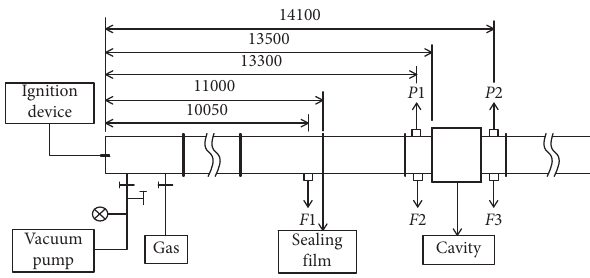
Figure 10: Layout of sensor and cavity structure (unit: mm).